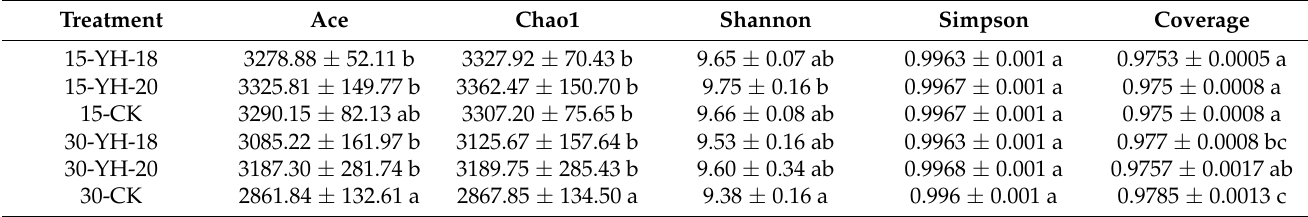
Table 2. Richness and diversity indices of bacteria in different treatments.